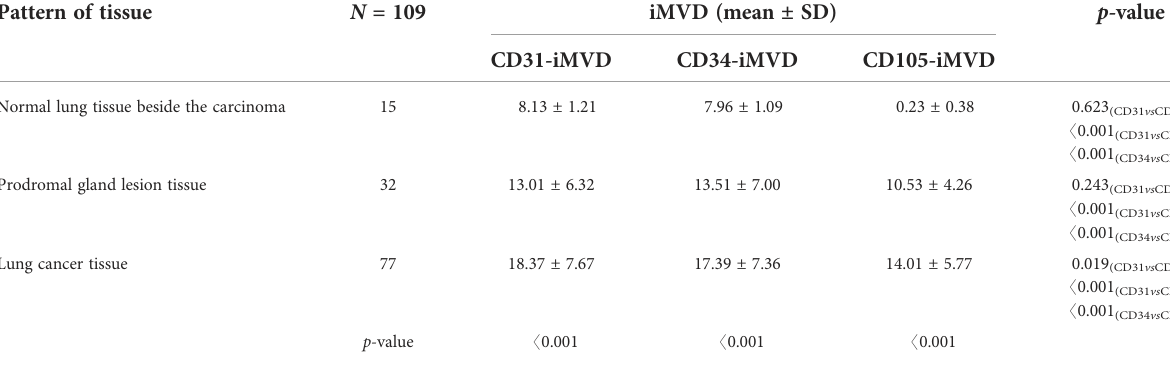
TABLE 1 y Expression of CD31-, CD34-, and CD105-labeled iMVD in lung cancer tissues, paracancer normal lung tissues, and proglandular lesions.